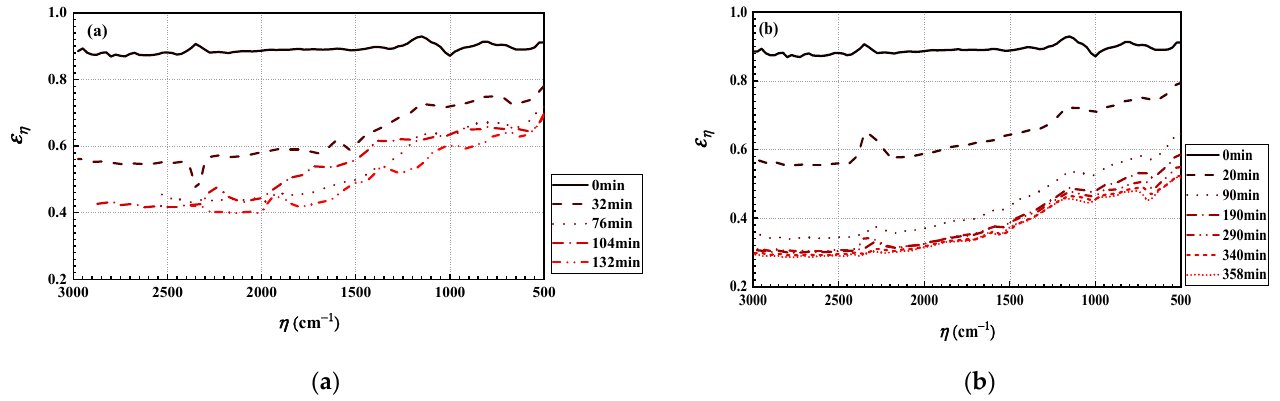
Figure 2. Spectral emittance of ash deposits as a function of the deposition time: ( a ) bituminous ash deposit; ( b ) sub-bituminous ash deposit.